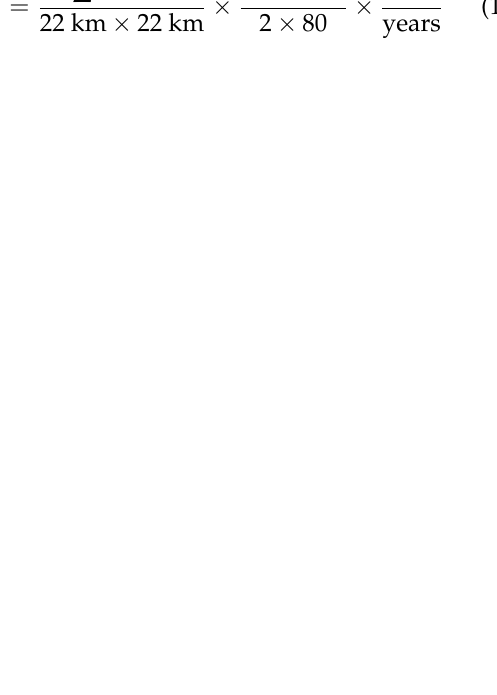
Figure 2. Methodology flowchart of the study.